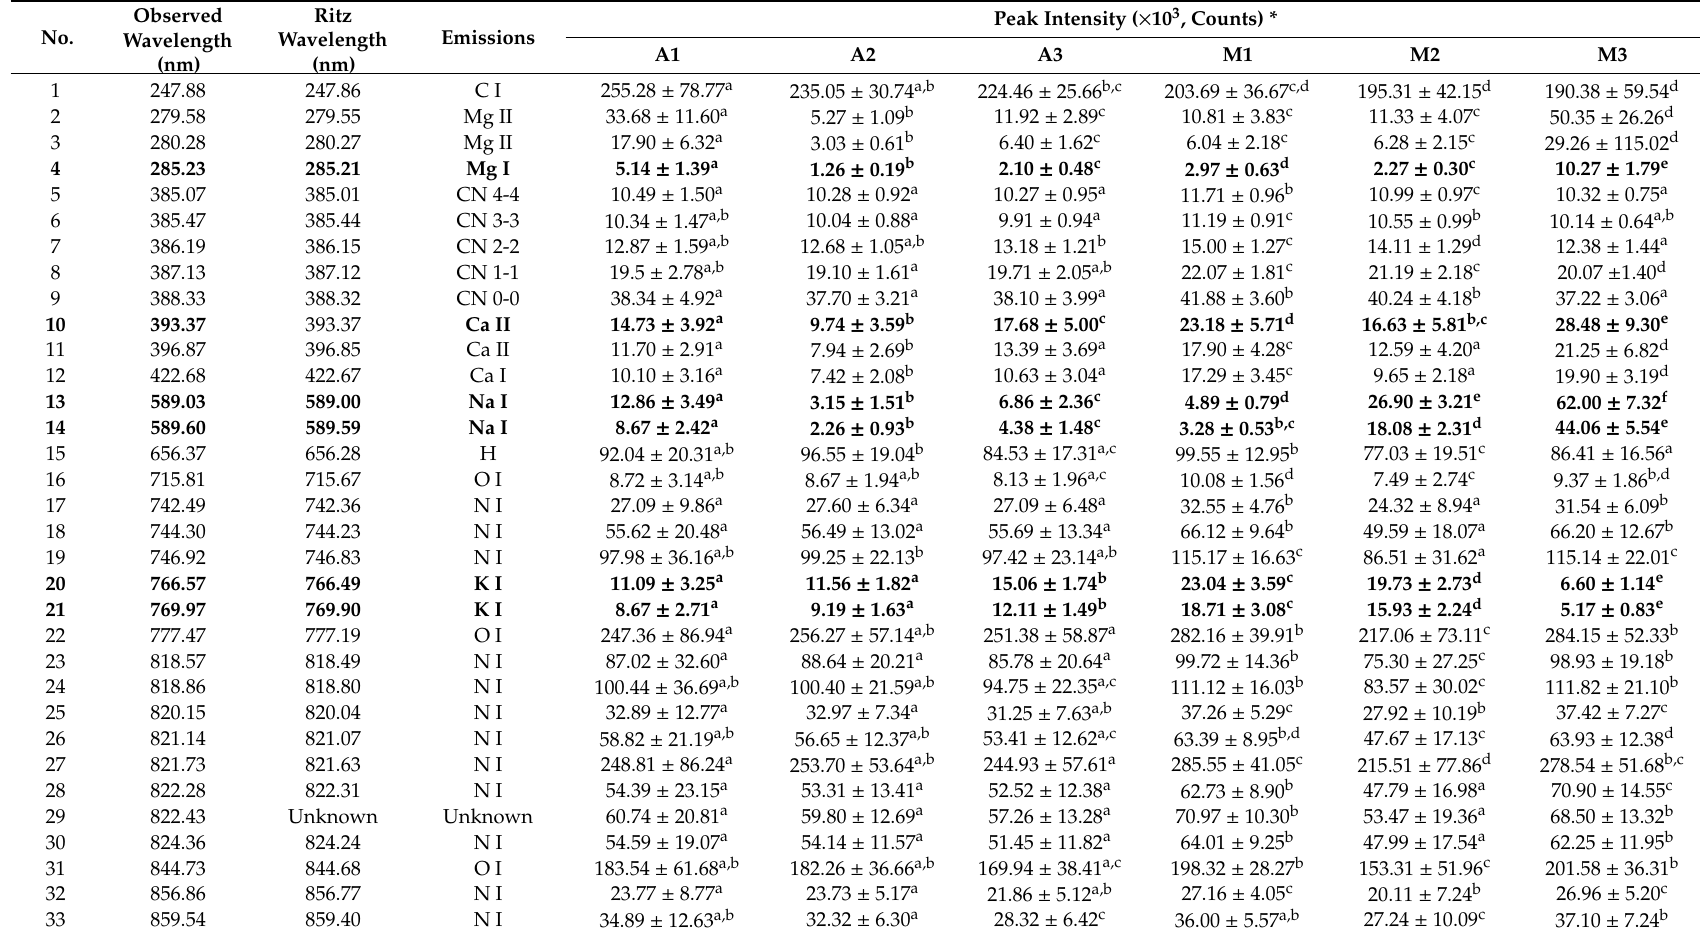
Table 2. Peak intensity of the main emissions from